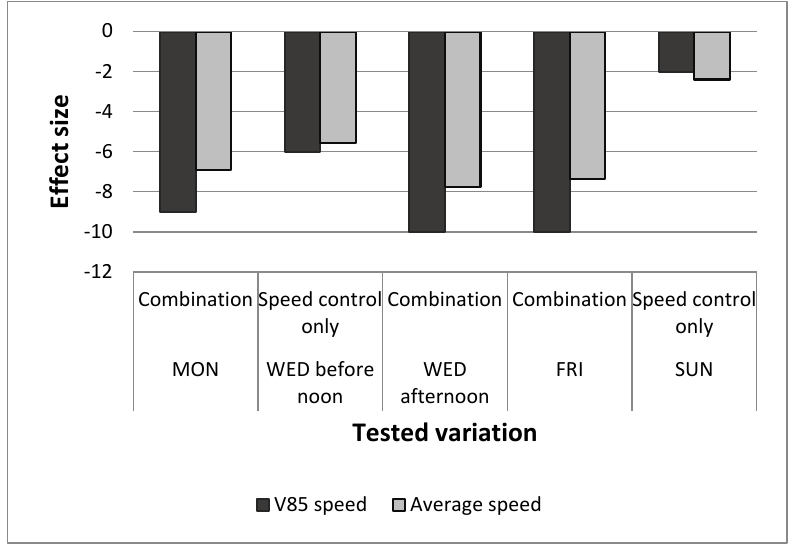
Figure 3. Effects on average speed and V85 speed for 2 types of interventions (regional police unit 1).